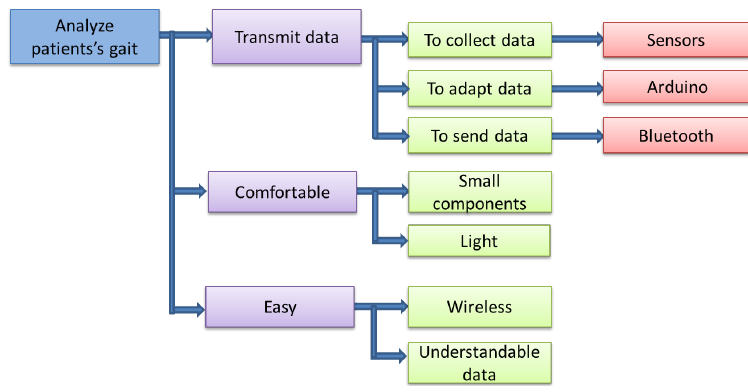
Figure 14. Design